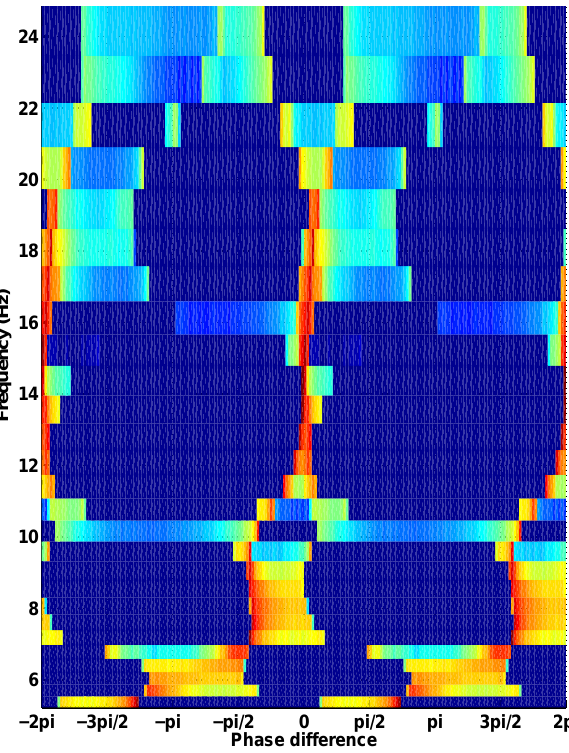
Fig. 10. The ω − k joint spectrum calculated from the two perpen- dicular electric field components E 42 and E 23 for the second event.